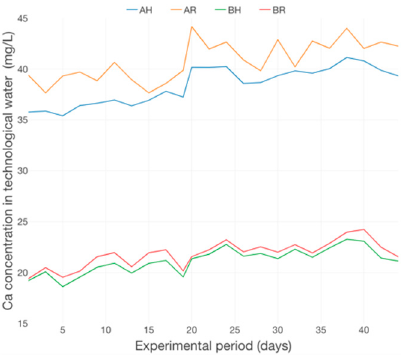
Figure 23. The dynamics of Ca concentration in technological water for each of the experimental variants.